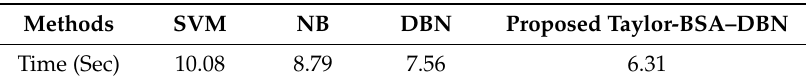
Table 11. Computational